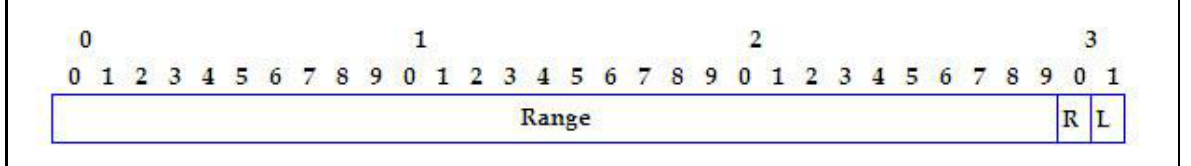
Figure 4. SERVER_OFFER message format.